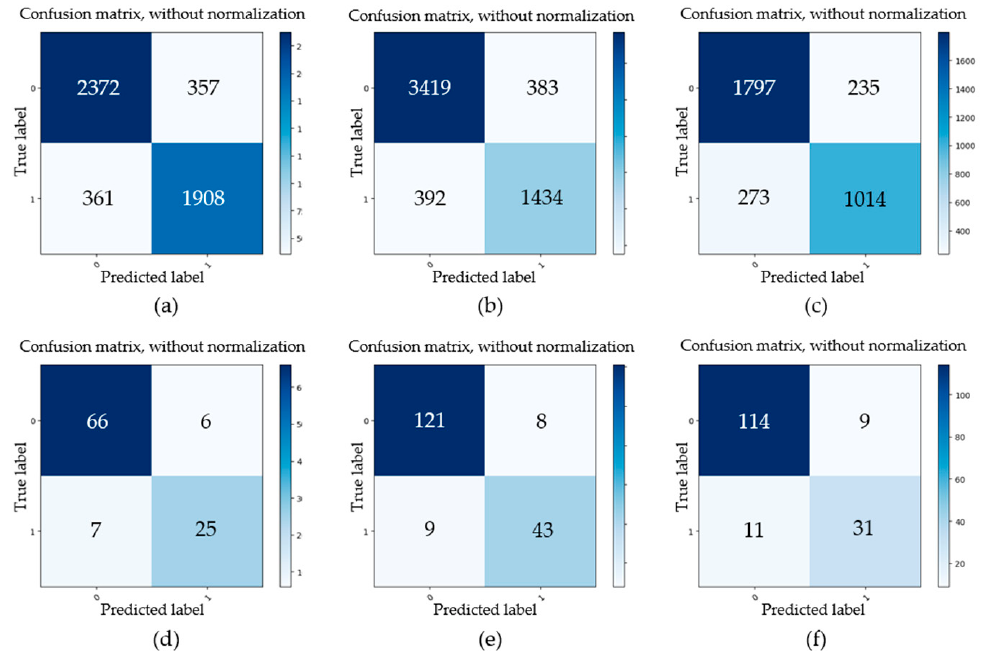
Figure 12. Evaluation parameters of gear pitting and TS under different illumination conditions. (a) I illumination (pitting); (b) II illumination (pitting); (c) III illumination (pitting); (d) I illumination (TS); (e) II illumination (TS); (f) III illumination (TS).